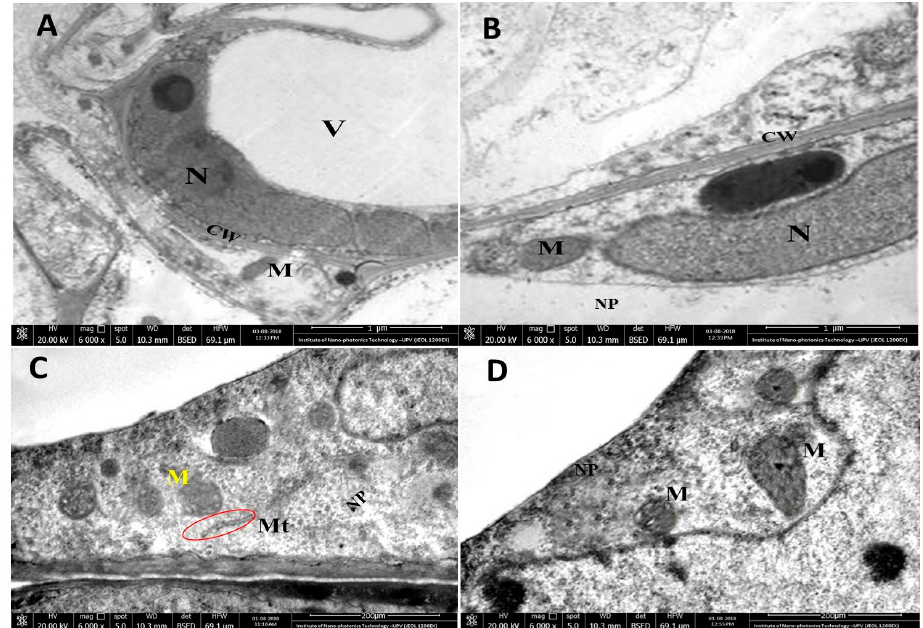
Figure 13. TEM micrographs showing internalization and translocation of rGO-CuO NPs (NP) in tomato root cells upon exposure to 100 mg/L of NP aqueous suspensions for 1 h. ( A ) Control (untreated) tomato root cells showing normal architecture of cell wall (Cw), nucleus (N), integrated mitochondria (M), and vacuoles (V). ( B ) Tomato treated root cells showing normal cell organelles after translocation of NPs inside cellular tissue. ( C ) Magnified view of mitochondrion (M), microtubules (Mt), and cellular matrix of tomato treated cells. ( D ) Magnified view of mitochondrion (M) and cellular matrix of pepper treated. B-D panels show internalization of NPs at various sites of root cells.